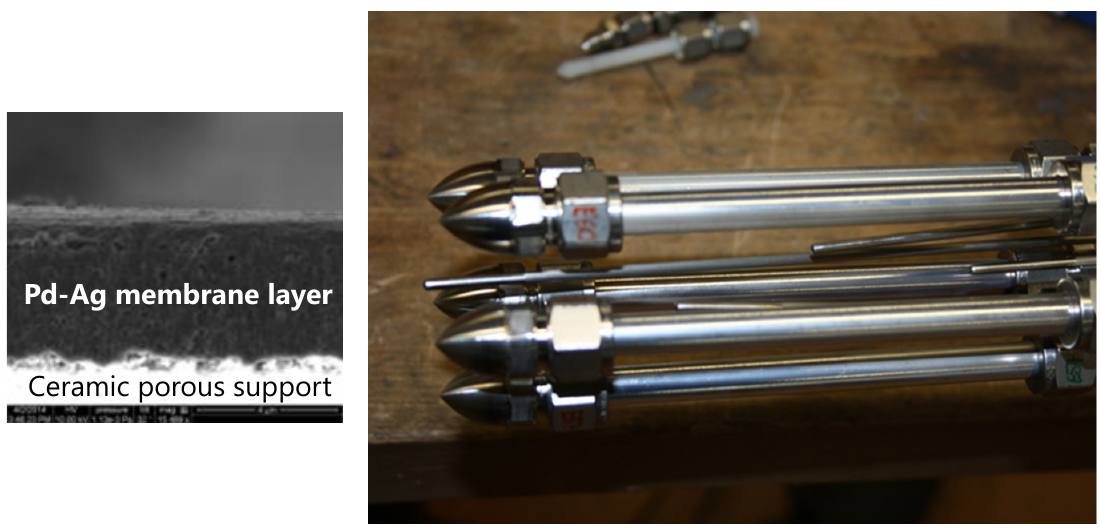
Figure 6. ( Left ) Cross section of a Pd ‐ Ag membrane; ( Right ) Pd ‐ Ag membranes to be integrated in the lab ‐ scale reactor.